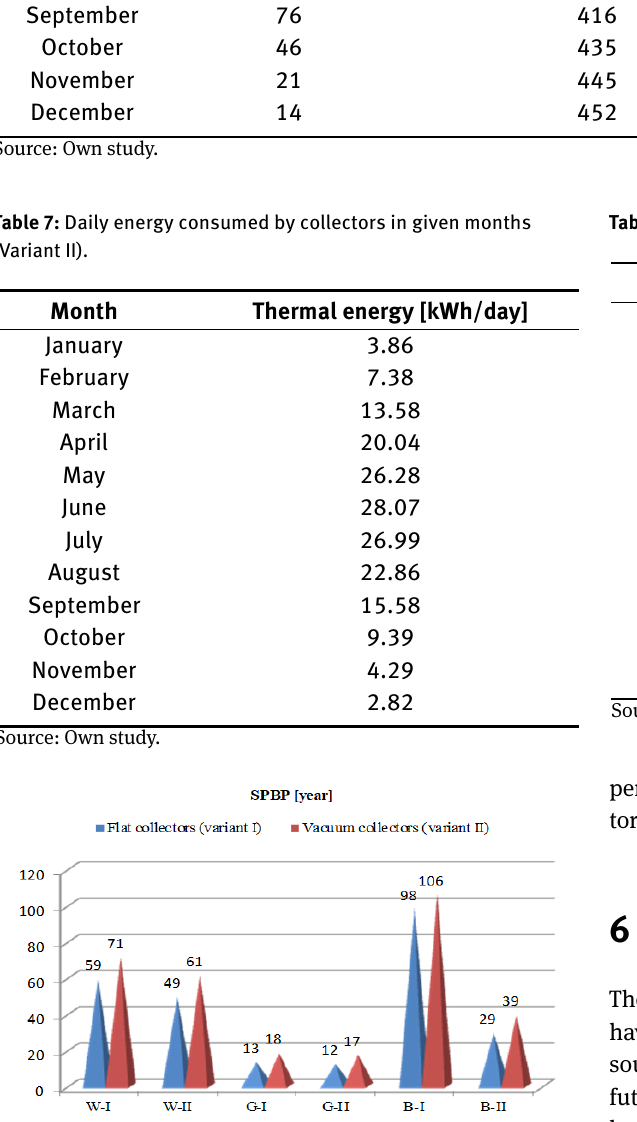
Figure 7: The period of return on investment in solar collectors.